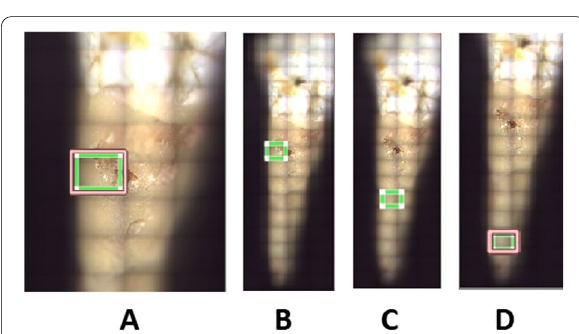
Fig. 4 A Example area scanned with confocal microscopy, B – D example of scans taken at the buccal cervical, buccal middle and buccal apical regions of tooth root,